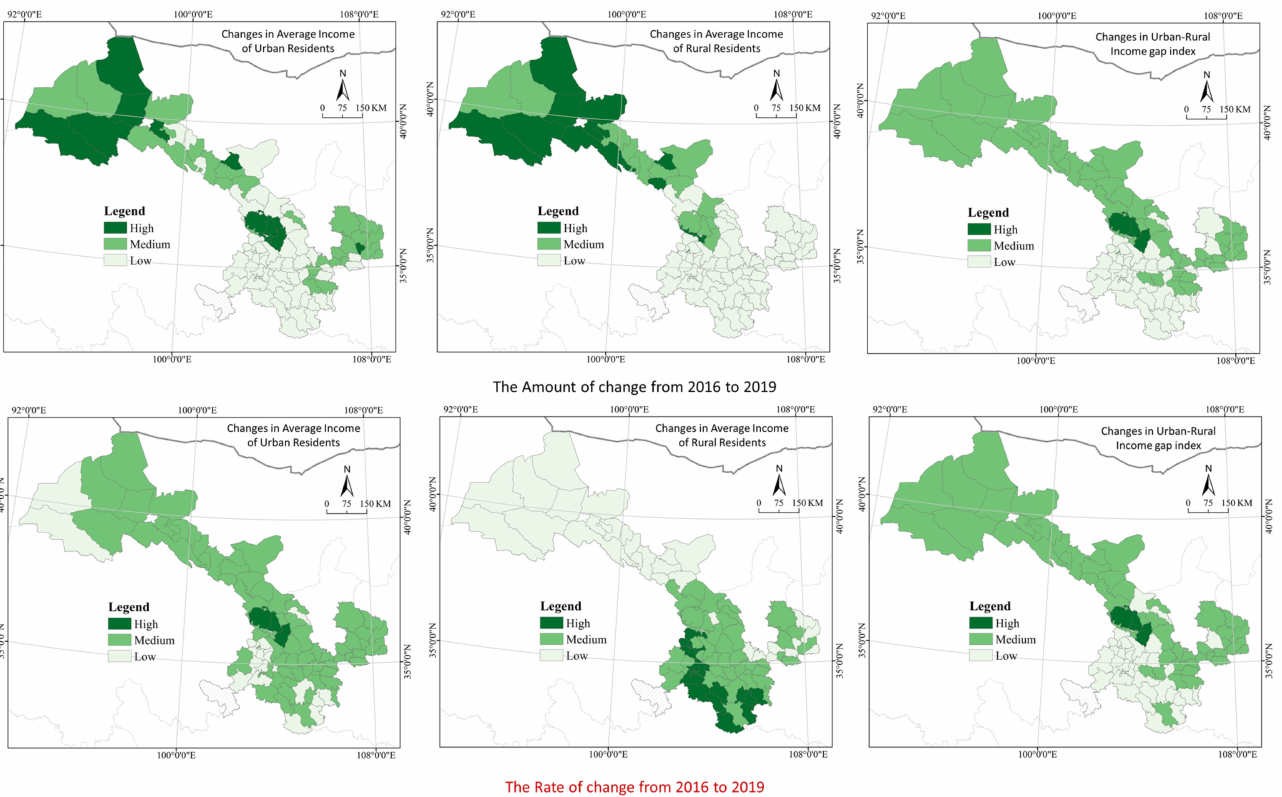
Figure 7. Analysis on Spatial heterogeneity of